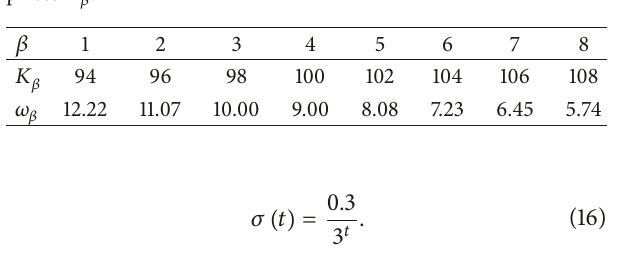
Figure 4: (a) Cost function Γ(𝜎) = ∑ 8 𝛽=1 [𝑢 𝐾 function and behavior of eight different points. (c) Estimated volatility functions for corresponding points.